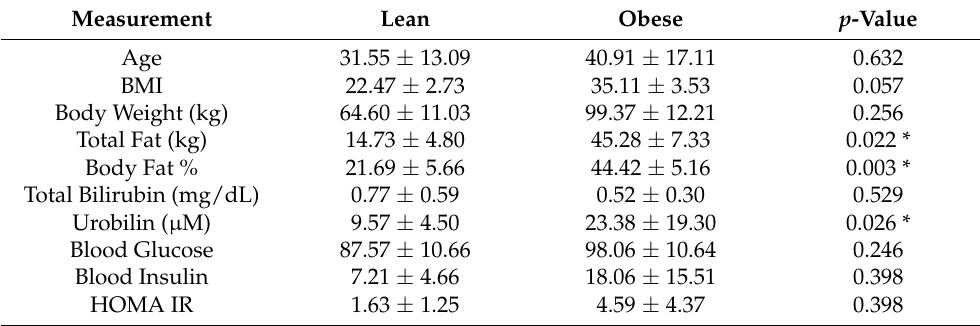
Table 1. Phenotyping of obese and lean humans.